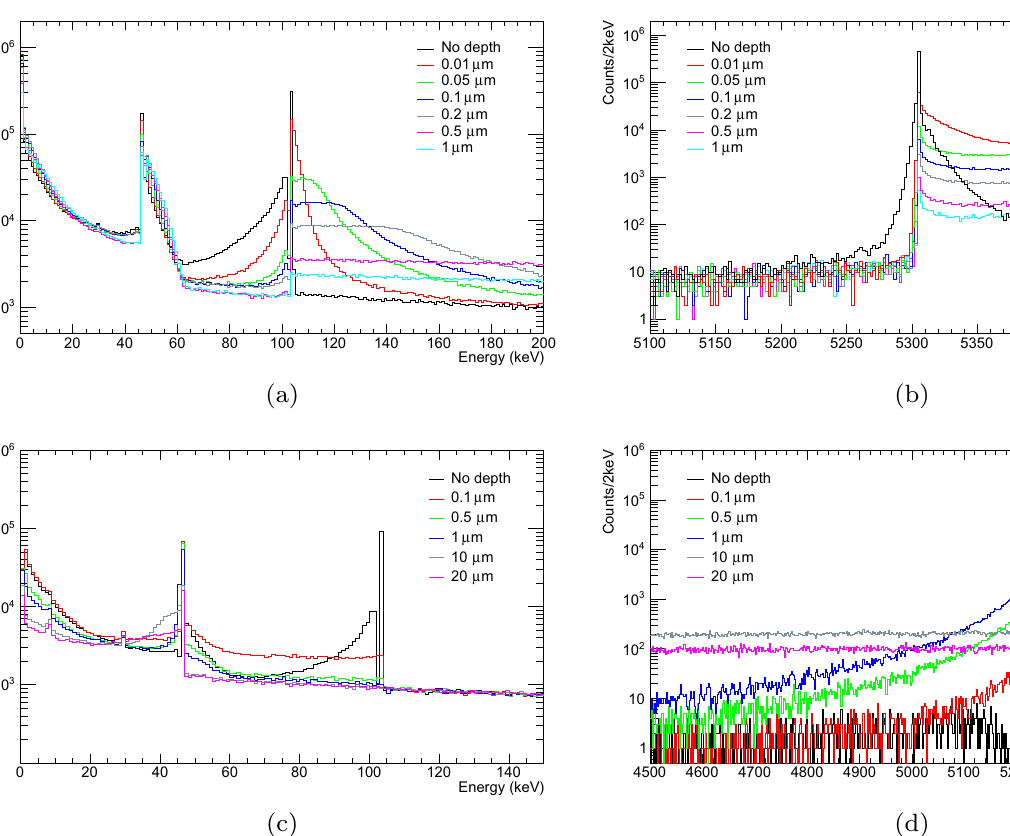
210 Pb contaminants distributed uniformly within various surface depths ofVikuitifilm.An α fromtheVikuitisurfaceleavesanamountofenergy in the crystal that can be as high as 5304 keV. Some spectral features like plateaux appear from surface contaminants within the depth on the scale of or less than 1 µ